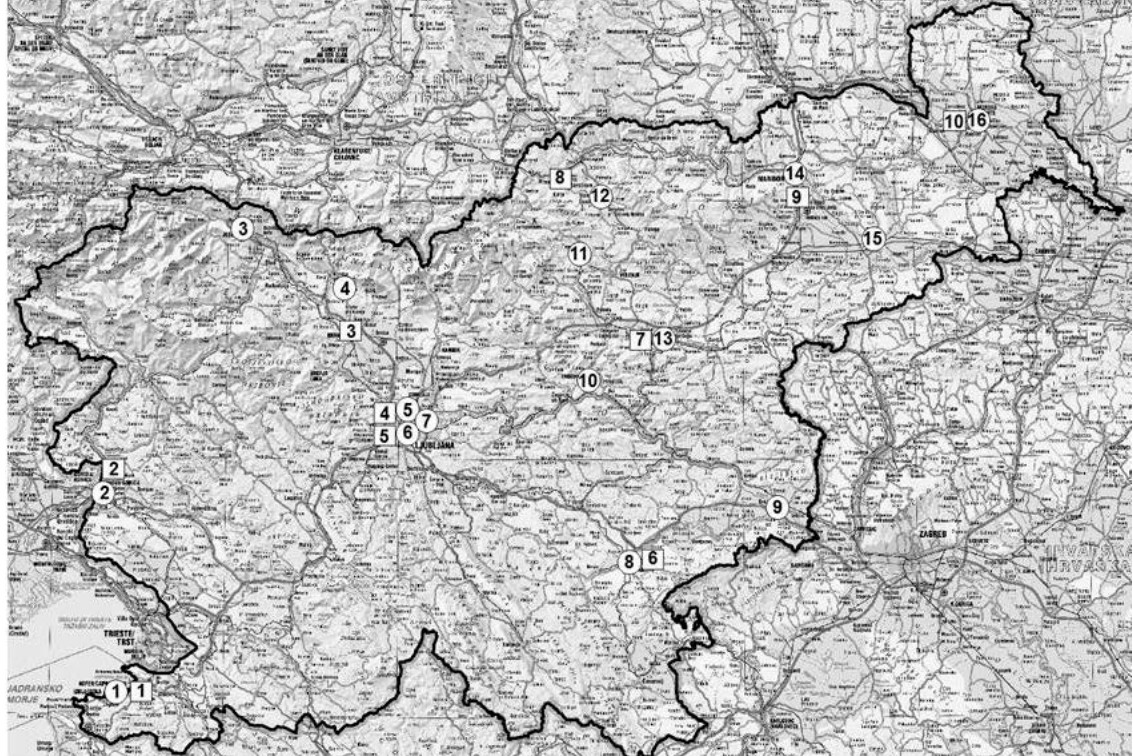
Figure 1. Healthcare institutions included in the